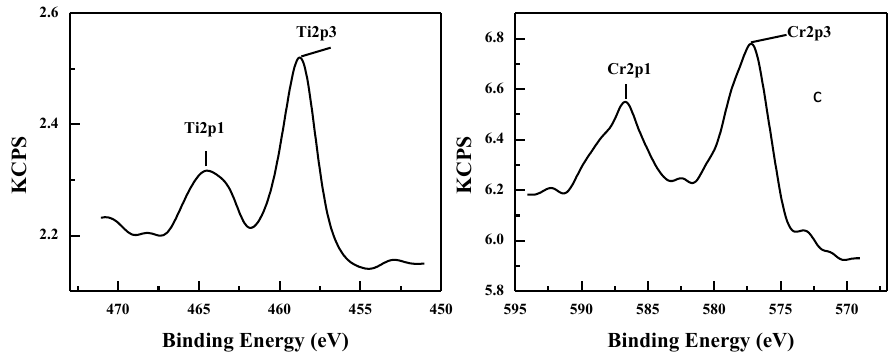
Figure 1. XPS patterns of ( a ) 2.9 wt%TiO 2 /SiO 2 -500; ( b ) 7.1 wt%Cr 2 O 3 -6.3 wt% NiO/SiO 2 -500; ( c ) 1.4 wt% TiO 2 -6.1 wt% Cr 2 O 3 /SiO 2 -500.